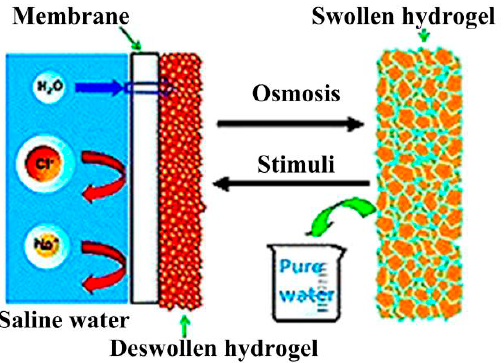
Figure 3. Schematic representation of the polymer hydrogel-forward osmosis desalination process. Reprinted from Reference [36] with permission from The Royal Society of Chemistry.